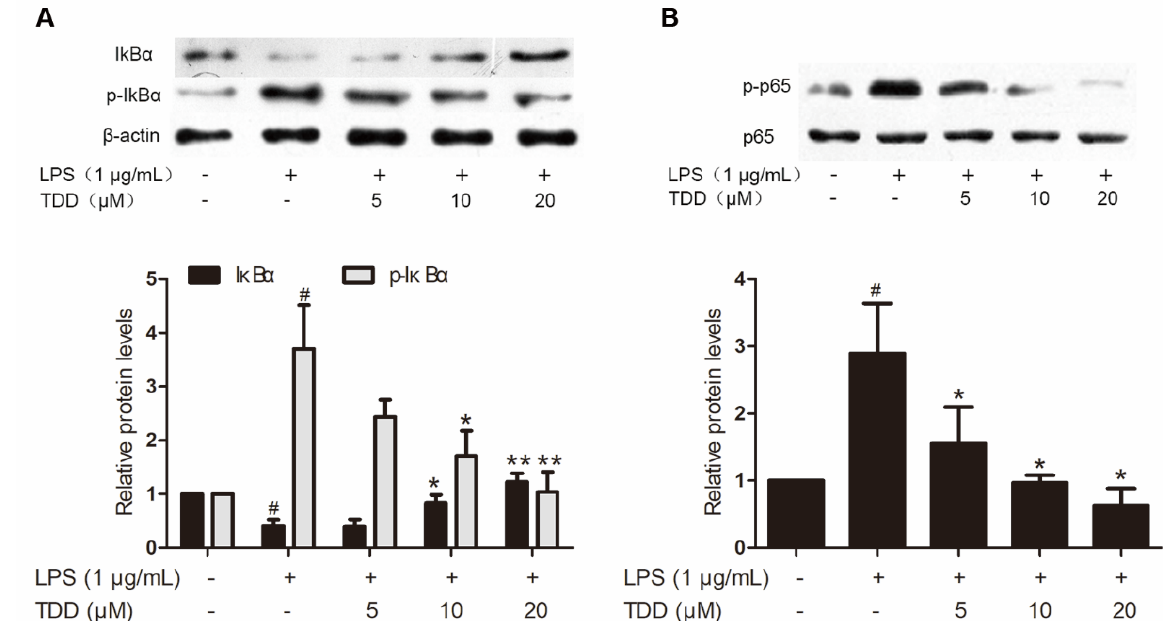
Figure 4. Effects of TDD on LPS-induced NF-κB activation in EA.hy926 cells. EA.hy926 cells were treated with various concentrations of TDD (5, 10, and 20 µM) for 4 h, and then LPS (1 μg/mL) was added for 0.5 h. ( A ) Effects of TDD on IκBα activation and IκBα degradation in LPS-stimulated EA.hy926 cells, and ( B ) effects of TDD on p65 activation in LPS-stimulated EA.hy926 cells. The data show the mean ± S.D. of three independent experiments. * p < 0.05 and ** p < 0.01, compared to the LPS (+) TDD (−) group. # p < 0.05 compared to the LPS (−) TDD (−) group.